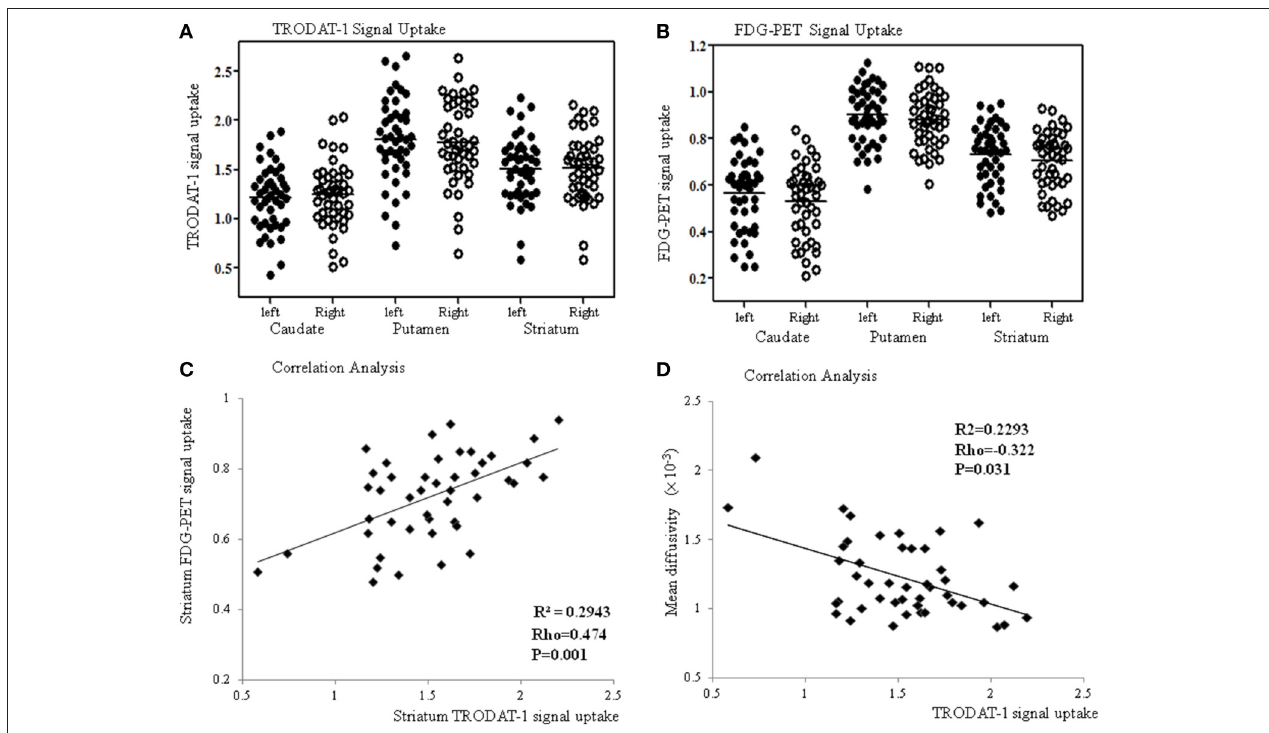
FIGURE 3 | The TRODAT-1 signals (A) or 18 F-fluoro-2-deoxyglucose positron emission tomography (FDG-PET) signals (B) are symmetrically distributed in the caudate, putamen and striatum. Significant correlations are found between the striatal FDG-PET and TRODAT-1 signals (C) or striatal mean diffusivity values and TRODAT-1 signals (D)